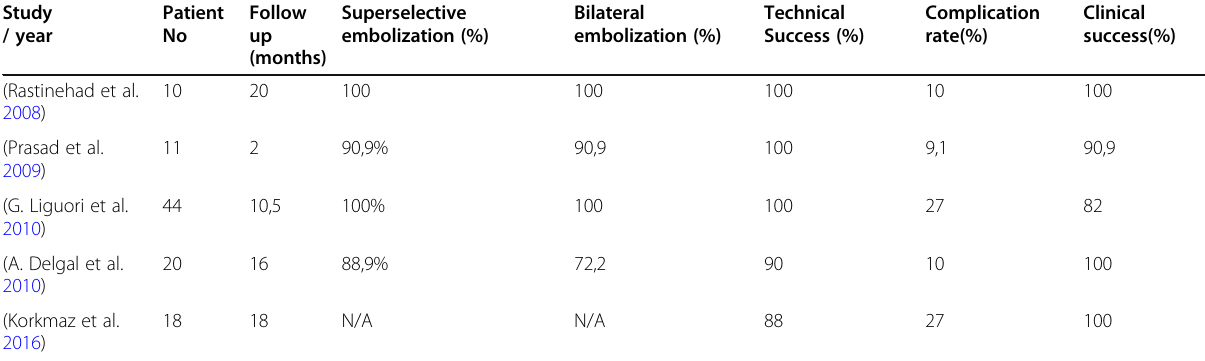
Table 3 Published series of embolization for intractable hematuria Study /